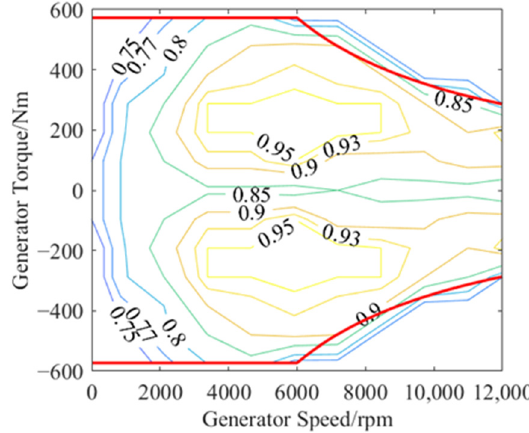
Figure 5. Generation efficiency